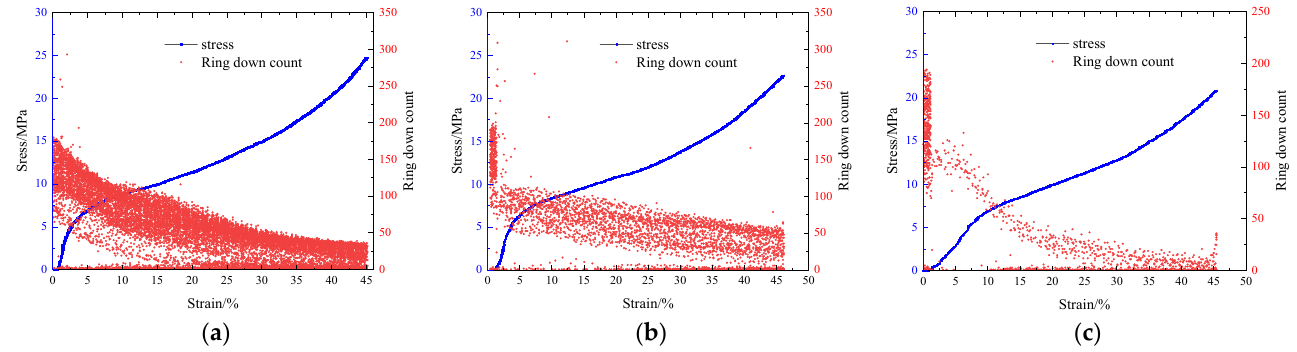
Figure 6. A representative AE waveform.